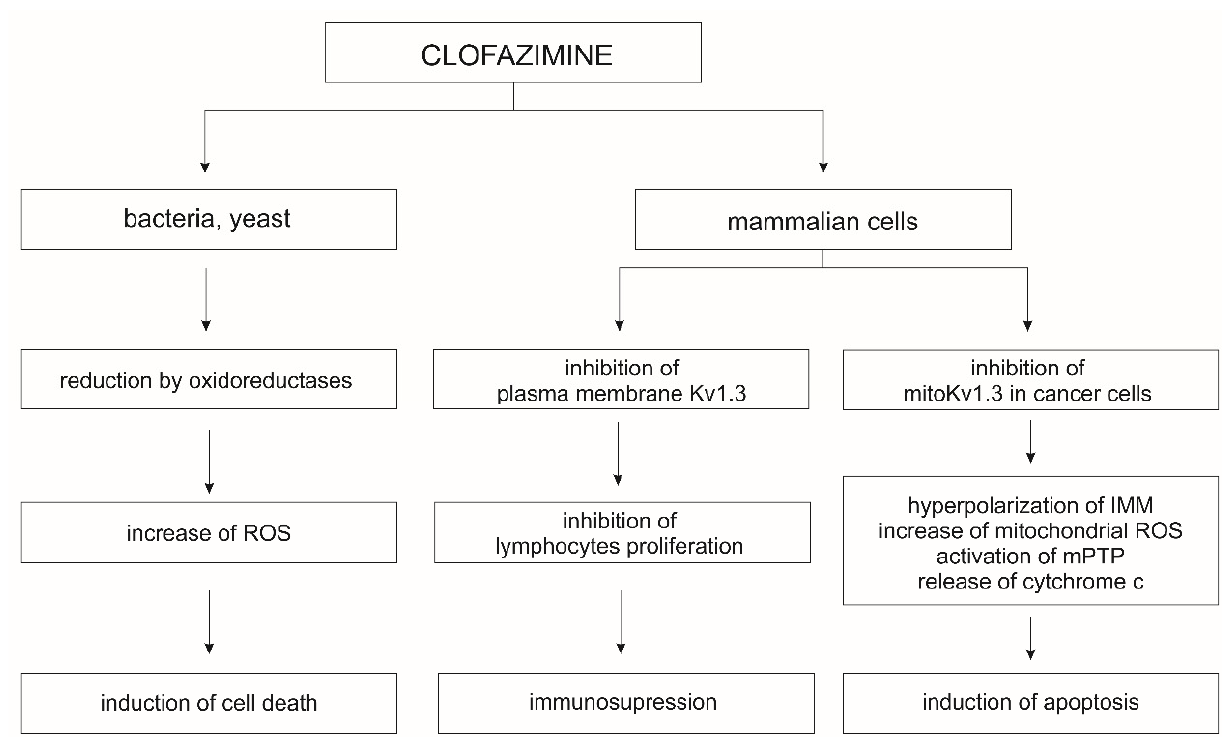
Figure 3. Diagram showing the multidirectional effects of clofazimine.